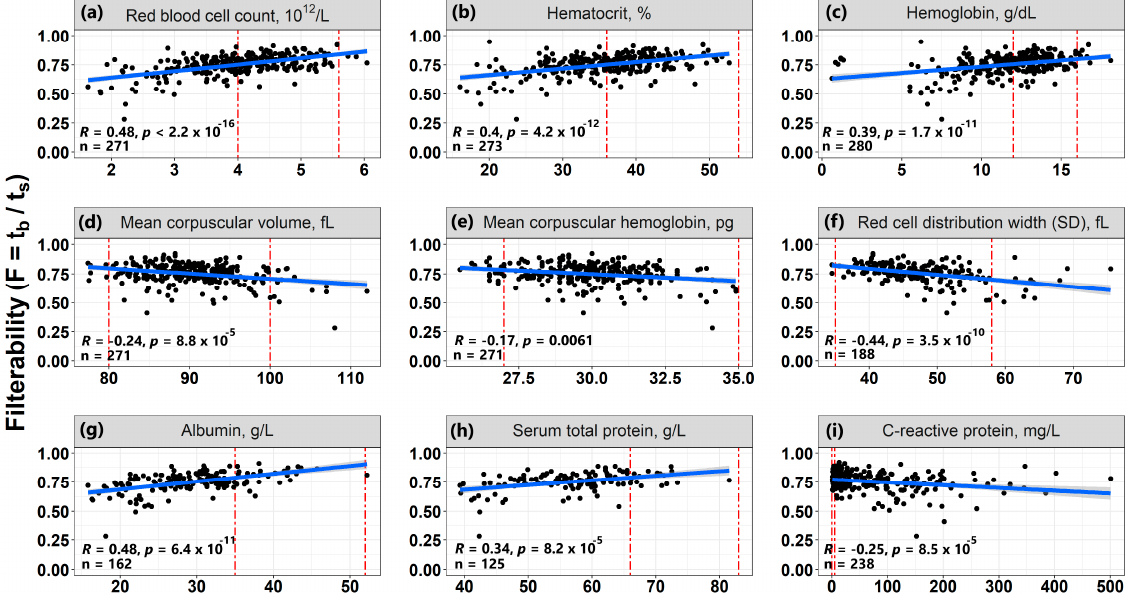
Figure 7. Correlations of some laboratory parameters with filterability (F) of RBCs from patients with COVID-19. Correlations F with the following parameters are presented: ( a ) Red blood cells count; ( b ) Hematocrit; ( c ) Hemoglobin; ( d ) Mean corpuscular volume; ( e ) Mean corpuscular hemoglobin; ( f ) RBCs distribution width by volume (as SD of average value); ( g ) Albumin; ( h ) Serum total protein; and ( i ) C-reactive protein. For all correlations, a linear approximation was used, which was characterized by the Spearman correlation coefficient (R). Gray ranges are confidence intervals of approximation line. The vertical red lines show the normal range for each of the